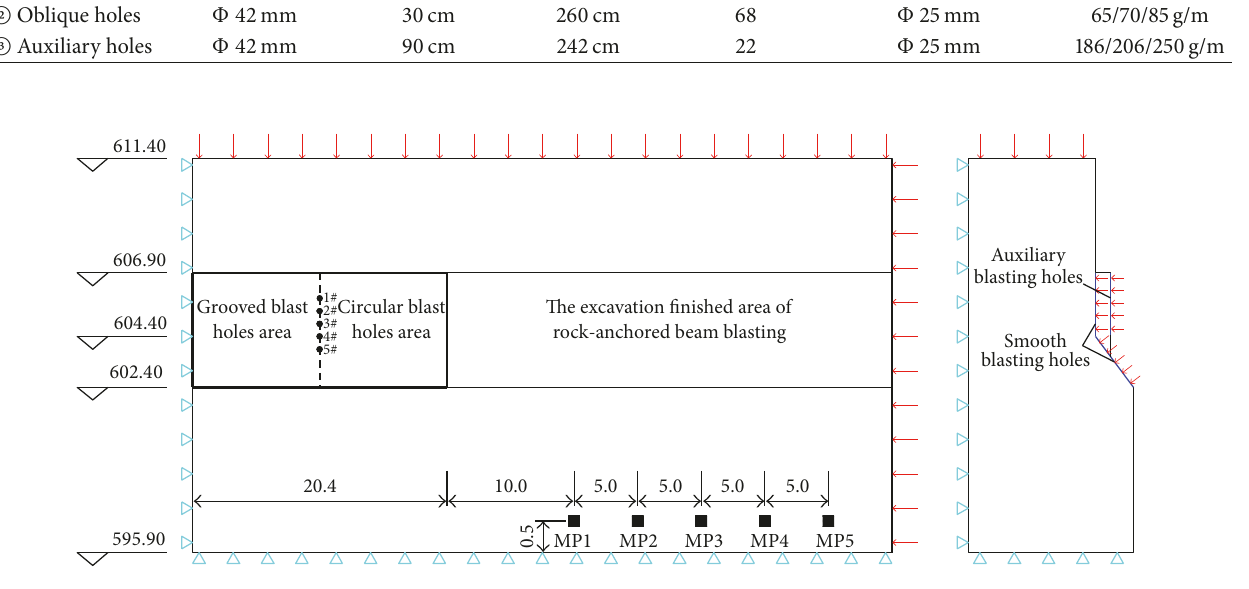
Figure 8: The front view and side view of blasting test of rock-anchored beam (unit: m).